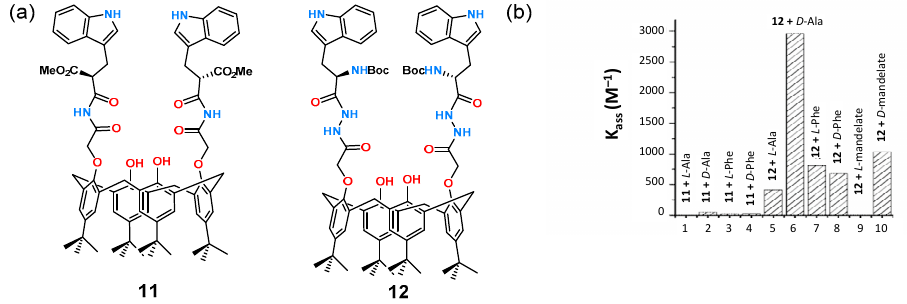
Figure 6. ( a ) Structures of receptors 11 and 12 and ( b ) their chiral recognition properties. The receptors have two tryptophan molecules symmetrically attached via amide bonds to form an anion binding site. Affinity studies for a series of chiral carboxylate anions derived from mandelic acid, phenylglycine, N -Boc-phenylglycine, and N -Boc-phenylalanine were performed by fluorescence titration in DMSO. The titration results show the dependence of the stability constants ( K ass ) of the formed complexes of receptors 11 and 12 with the aforementioned anions (Figure 6b). As can be seen, receptor 11 , having only two amide functions, practically did not interact with the tested anions, while receptor 12 showed very good chiral recognition toward a pair of enantiomers of alanine and mandelic acid anions.